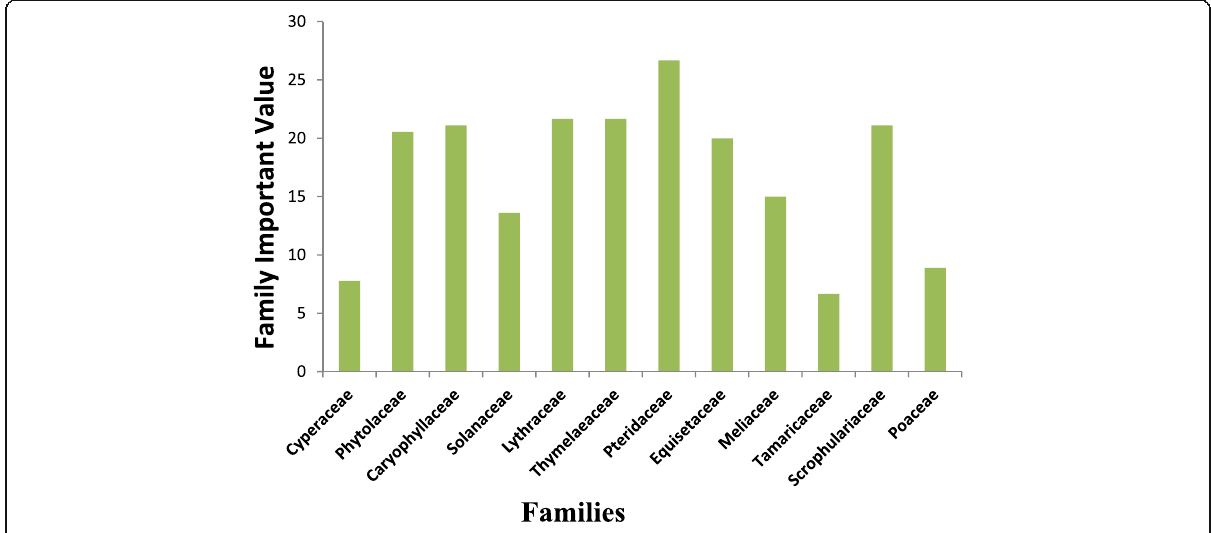
Fig. 6 Family importance value of medicinal plants utilized for skin disorders in Northern